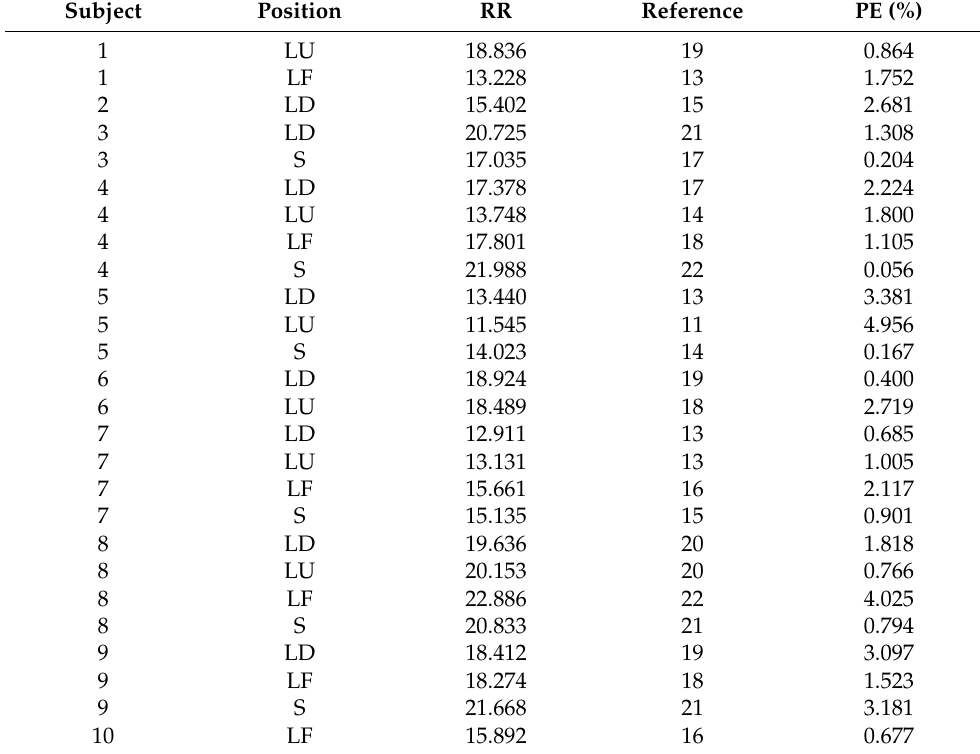
Table 7. Performance for all the subjects of the CNN model using MCV as input.